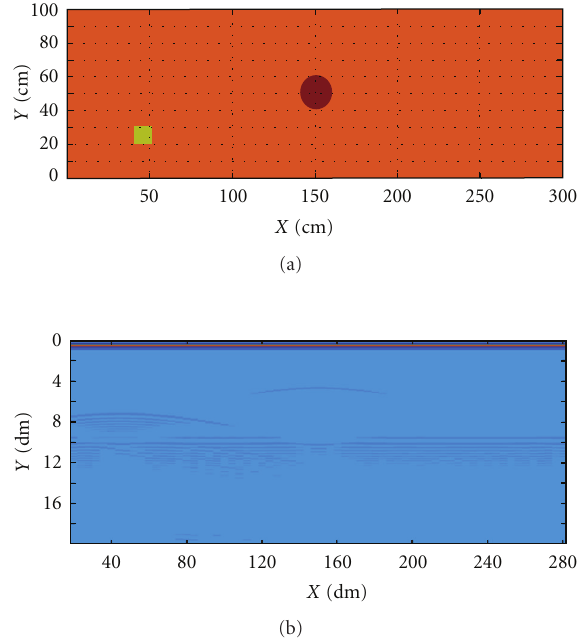
Figure 7: (a) Two scatterers are located within the wall, (b) corresponding